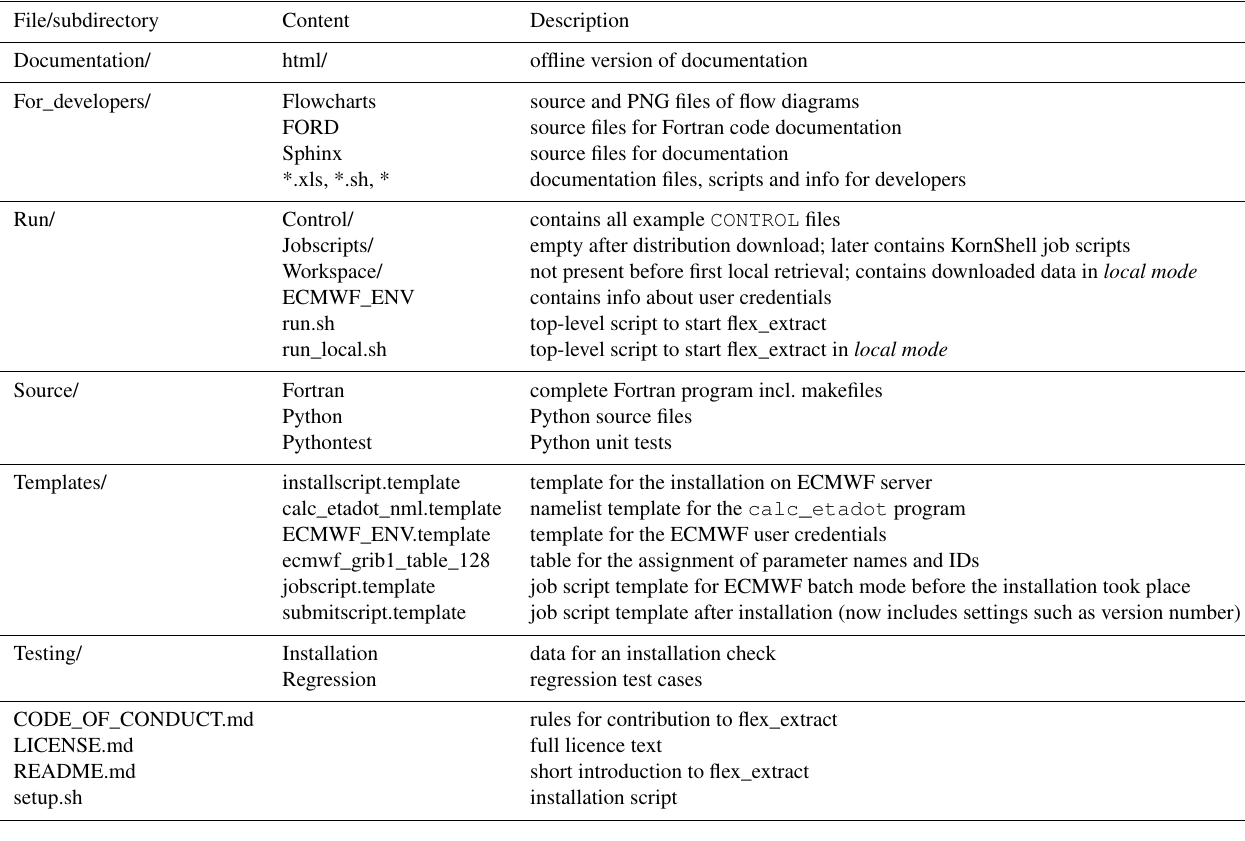
Table 5. Directory structure of the flex_extract v7.1 root directory.